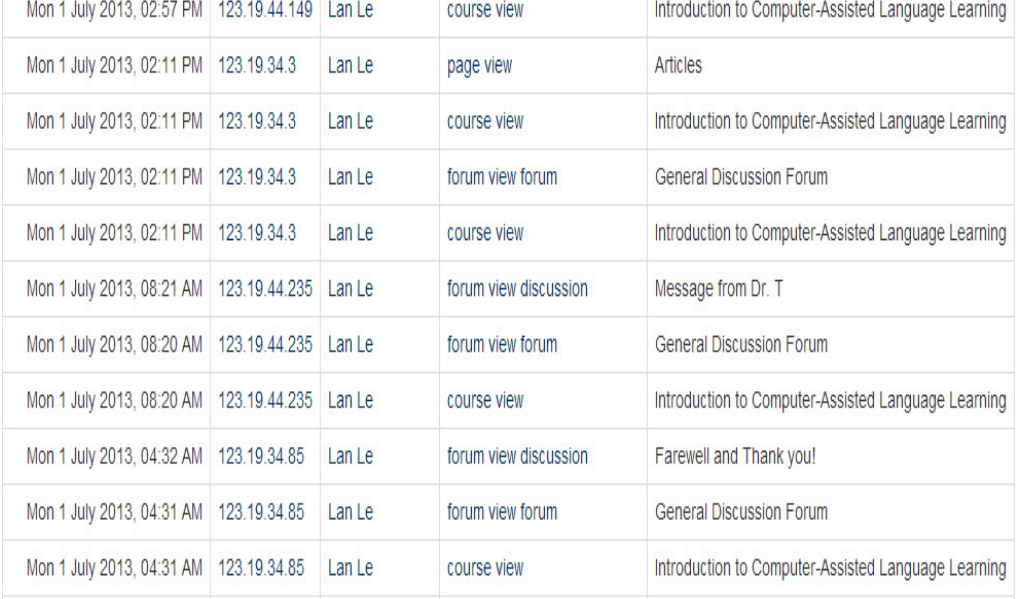
Figure 4 . Screenshot of a learner’s login